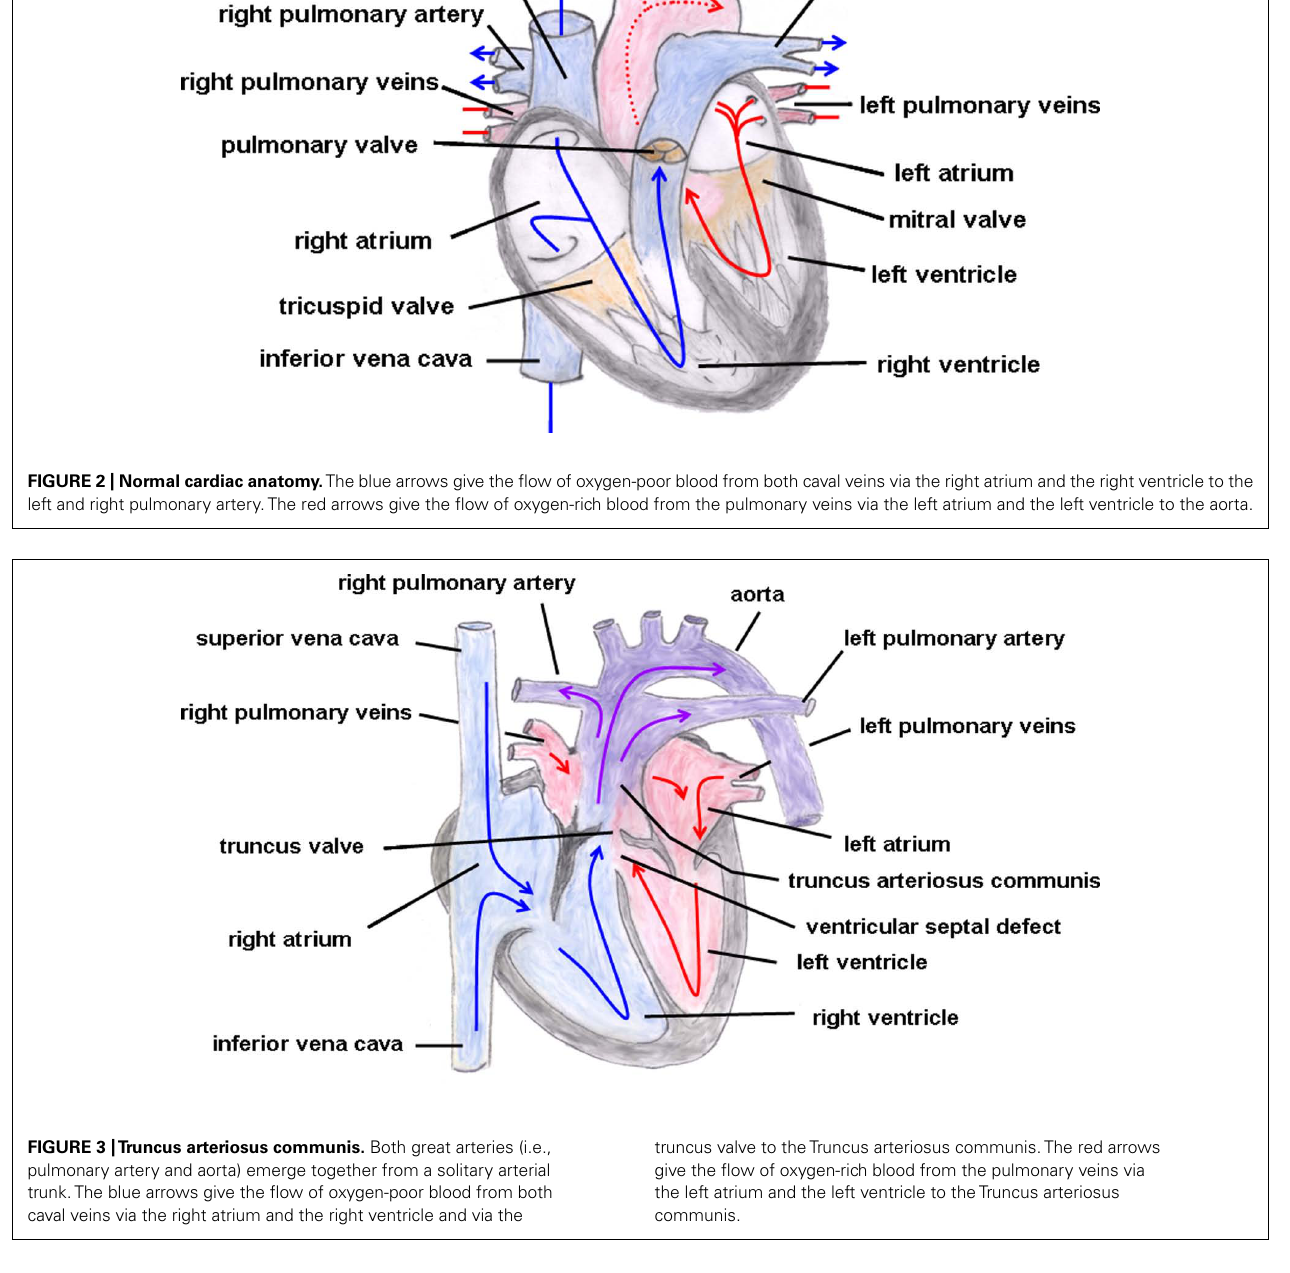
FIGURE 3 |Truncus arteriosus communis. Both great arteries (i.e., pulmonary artery and aorta) emerge together from a solitary arterial trunk.The blue arrows give the flow of oxygen-poor blood from both caval veins via the right atrium and the right ventricle and via the